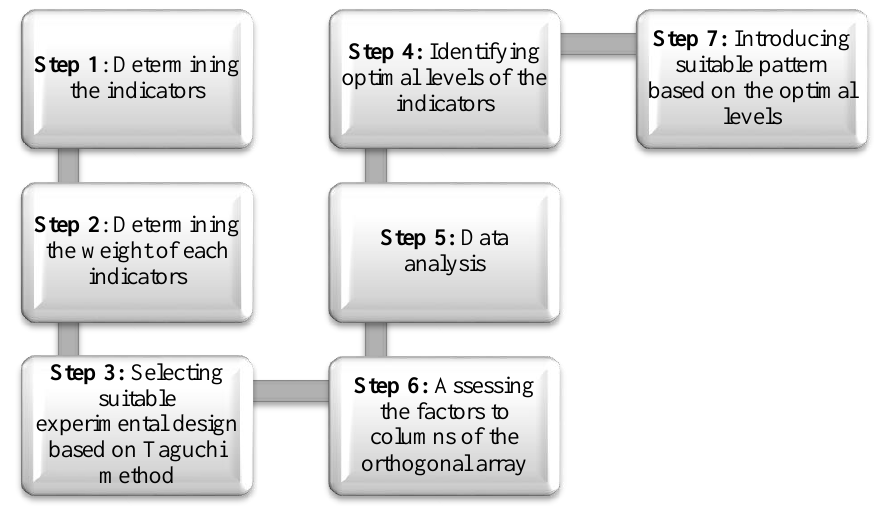
Figure 1. Taguchi method analysis process [51].